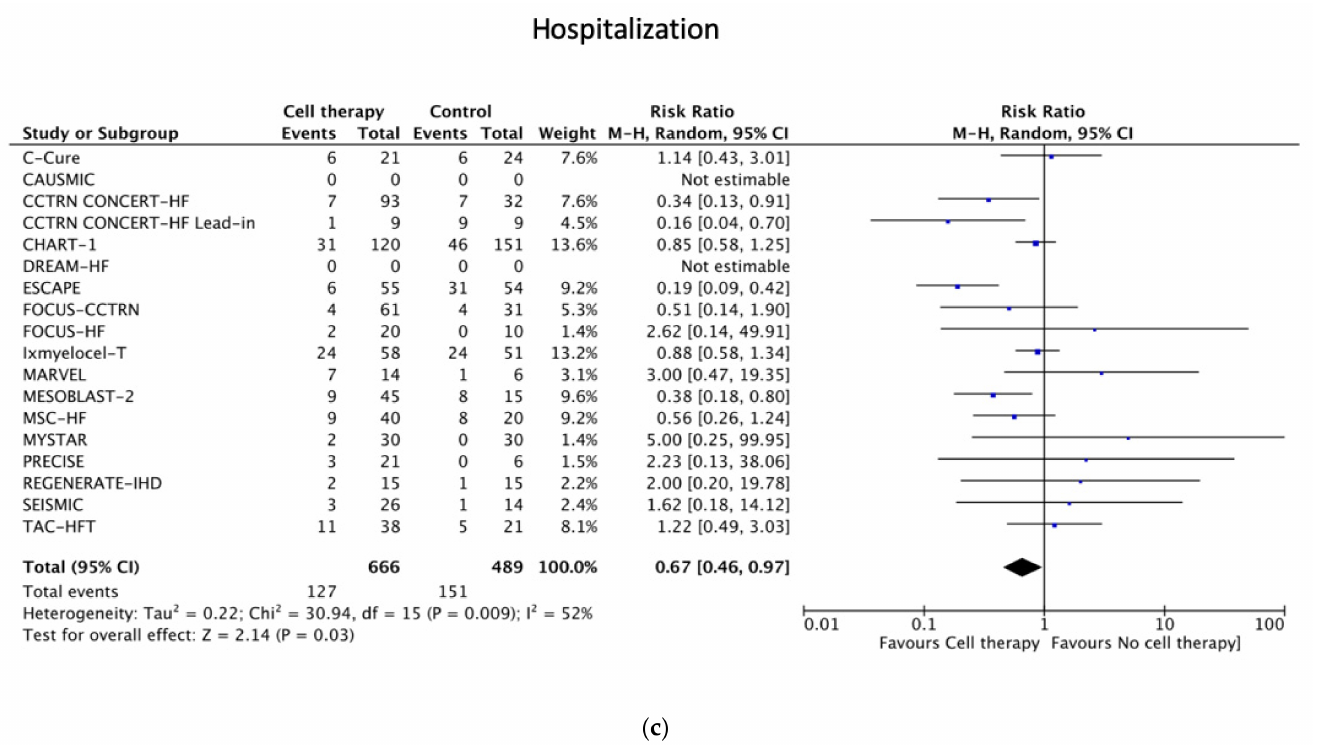
Figure 2. ( a – c ). Primary and secondary safety endpoints: clinical outcomes of the studies including patients randomized to receive percutaneous endocardial delivery of regenerative cells or controls. ( a ) Primary safety endpoint: all-cause mortality in patients randomized to receive percutaneous endocardial delivery of regenerative cells or controls. ( b ) Secondary safety endpoint MACEs (major adverse cardiac events) in patients randomized to receive percutaneous endocardial delivery of regenerative cells or controls. ( c ) Secondary safety endpoint: hospitalization in patients randomized to receive percutaneous endocardial delivery of regenerative cells or